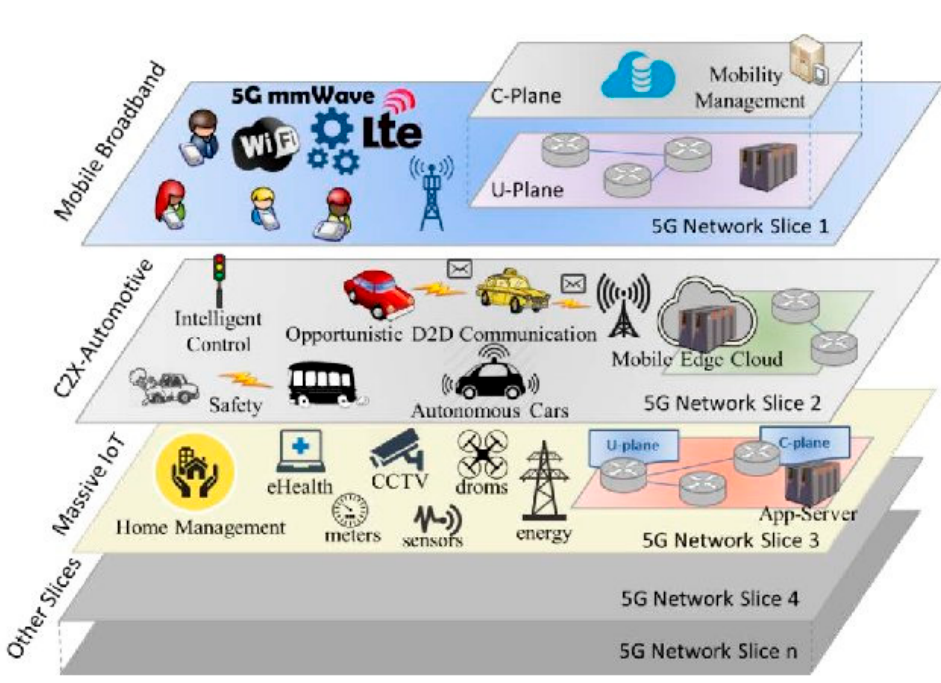
Figure 7. 5G network slices [33].